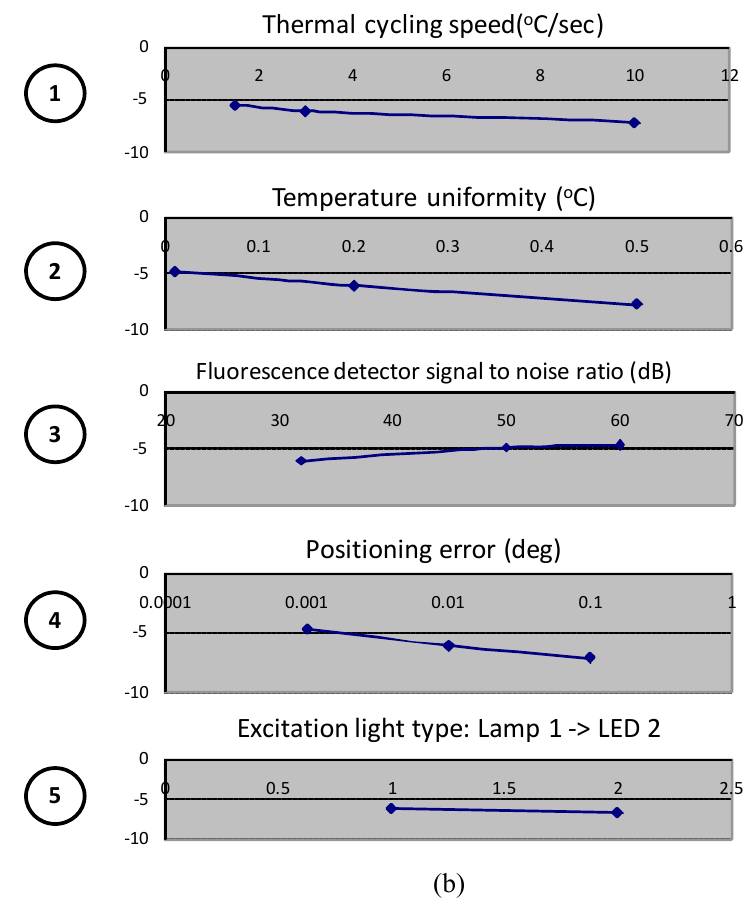
Figure 9. The analyzed results indicate two design parameters are critical: ① no moving part design and ② temperature control uniformity. The design parameters are listed in (a). The real-time PCR on chip prototype is shown in (b). The compact reactor chip design for high temperature uniformity and the fluorescence detection system without moving parts are shown in (c) and